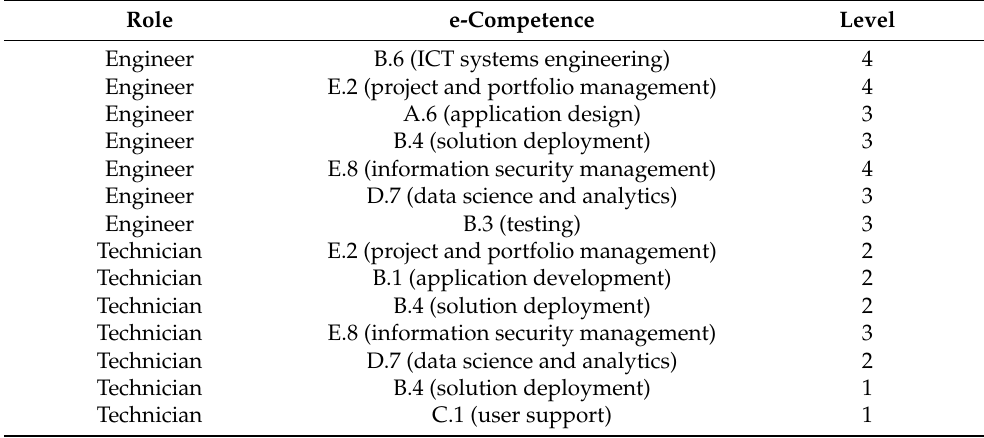
Table 4. Mapping of functions to the e-competence of